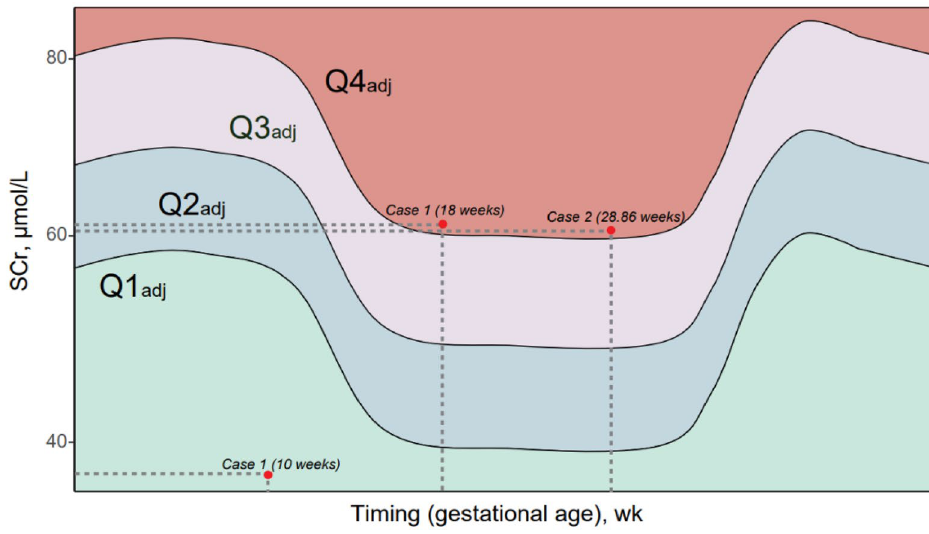
Figure 5. Application of the gestational age-specific serum creatinine distribution 16 in clinical